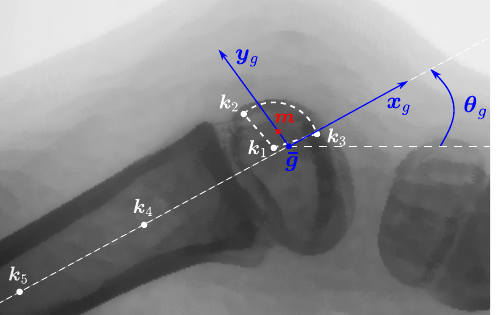
Figure 5. Keypoints of the femur and corresponding femur coordinate